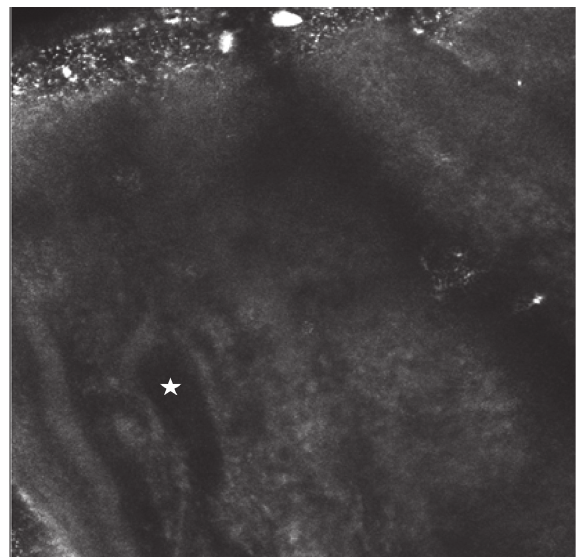
Figure 1: Homogenous tubular cyst-like structure (indicated by the star). The CaliberID 3000 handheld device was utilized. The depth of this image was taken at 60 μ m.